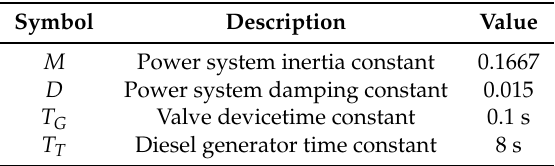
Table 1. System and diesel generator (DG) model parameters used for